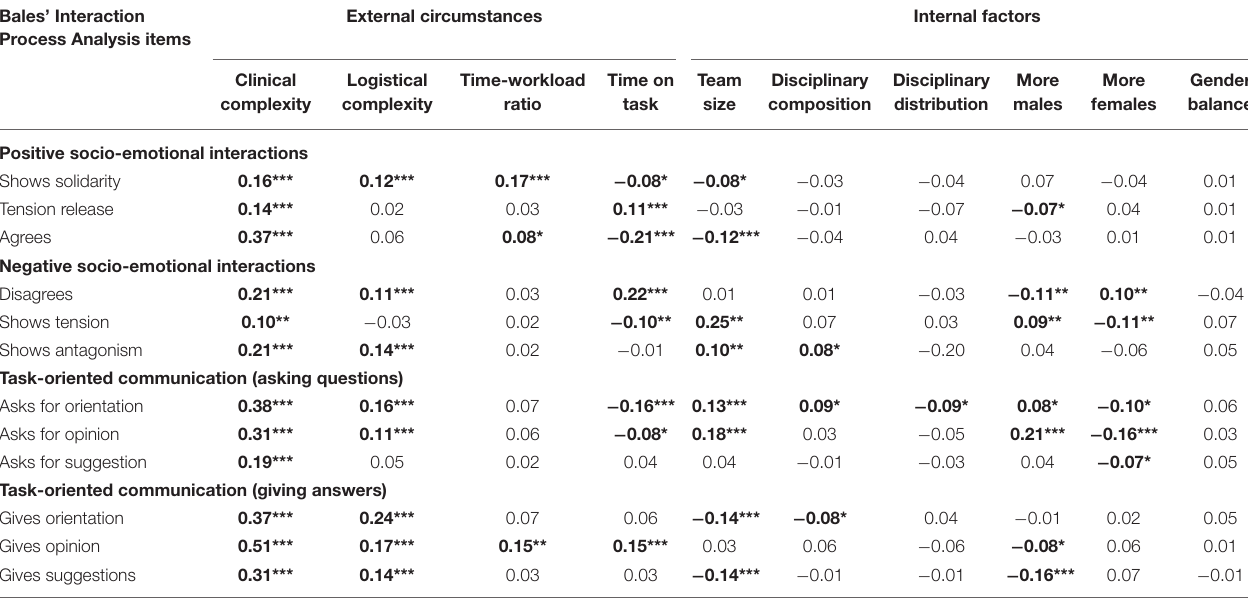
TABLE 4 | Partial correlations between Bales’ Interaction Process Analysis (Bales’ IPA) and external circumstances and internal factors. Bales’ Interaction Process Analysis